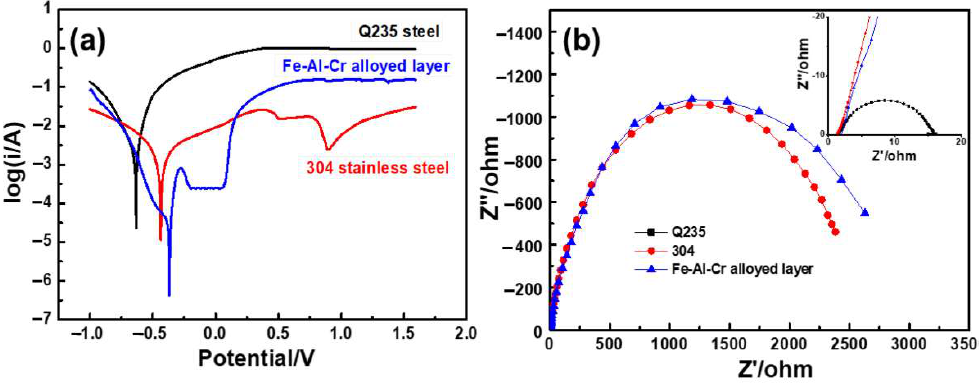
Figure 12. ( a ) The anodic polarization curves; ( b ) EIS curves of samples in a 0.5 mol/L H 2 SO 4 solution. Table 1. Calculation results of polarization curves of samples in a 0.5 mol/L H 2 SO 4 solution.